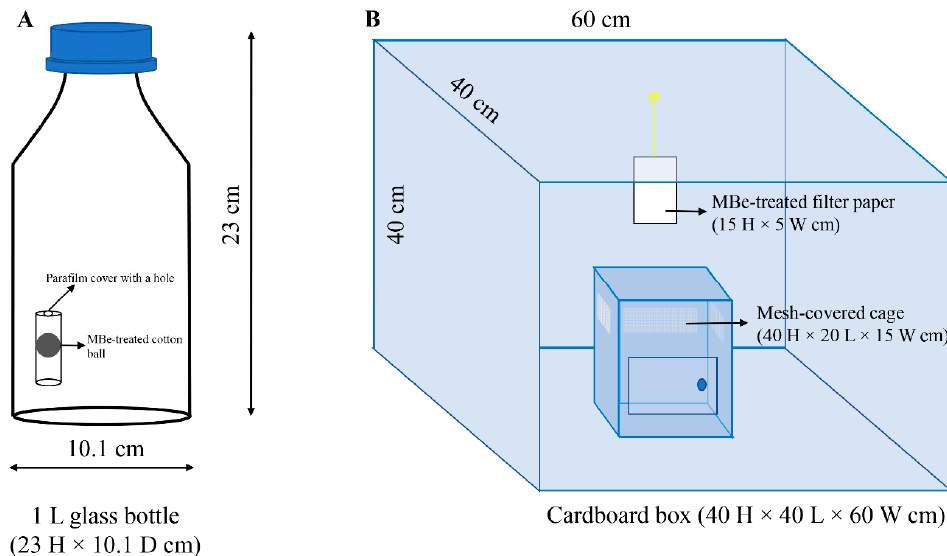
Figure 2. Experimental setups for testing the fumigation toxicity of methyl benzoate (MBe) against adults of Plodia interpunctella. ( A ) glass bottles (1 L) and ( B ) cardboard boxes were used as fumigation chambers.